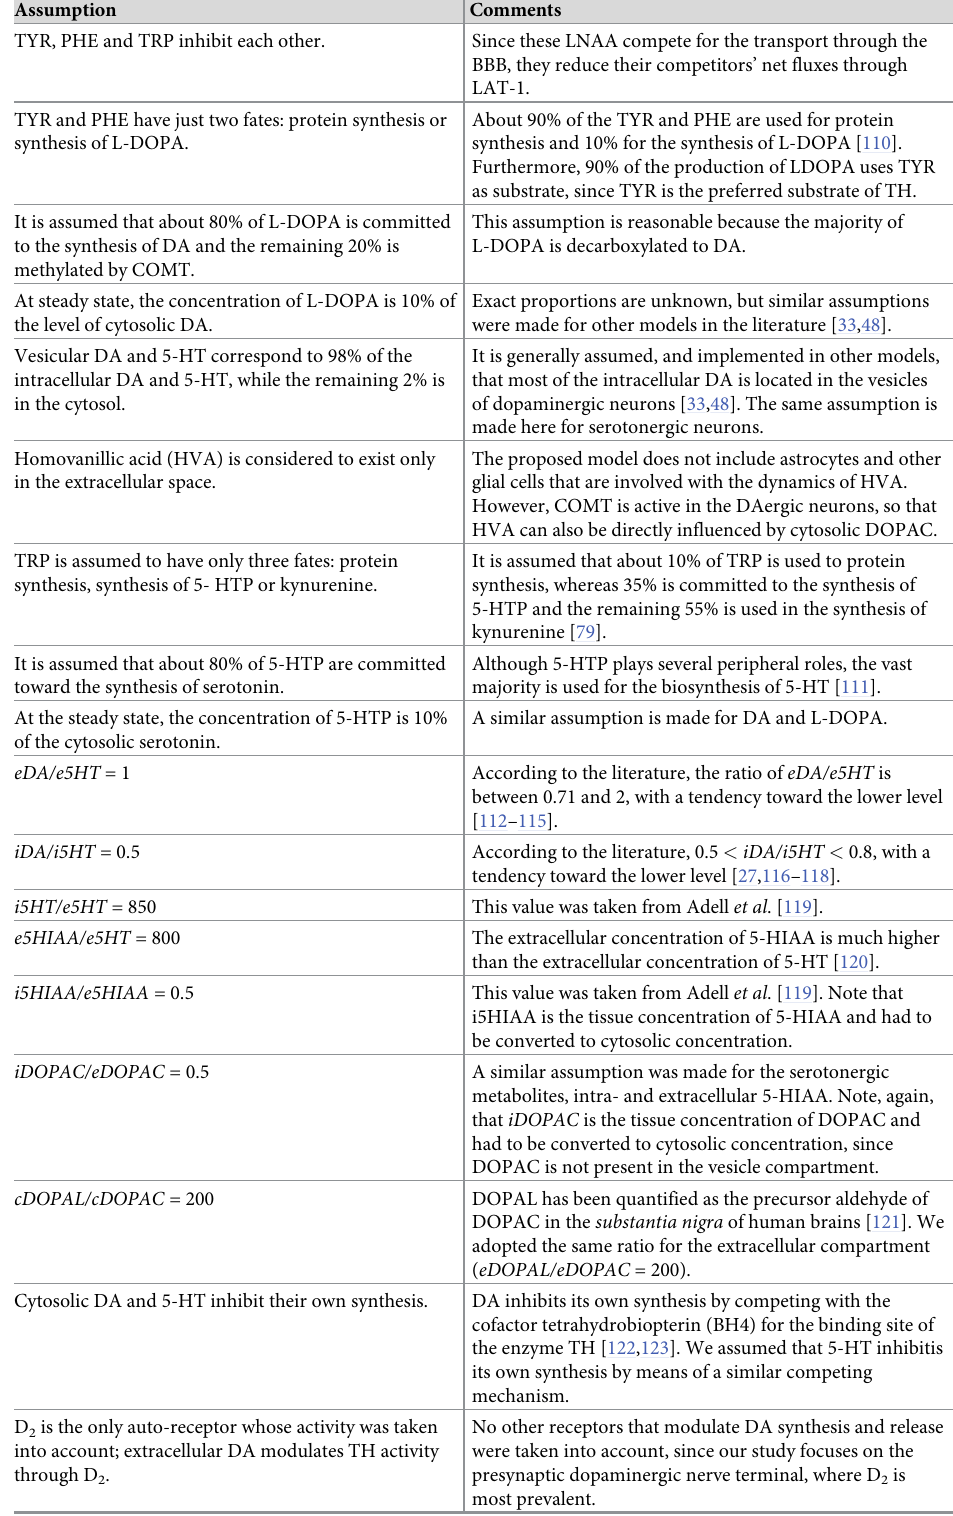
Table 3. Summary of the specific assumptions used during model